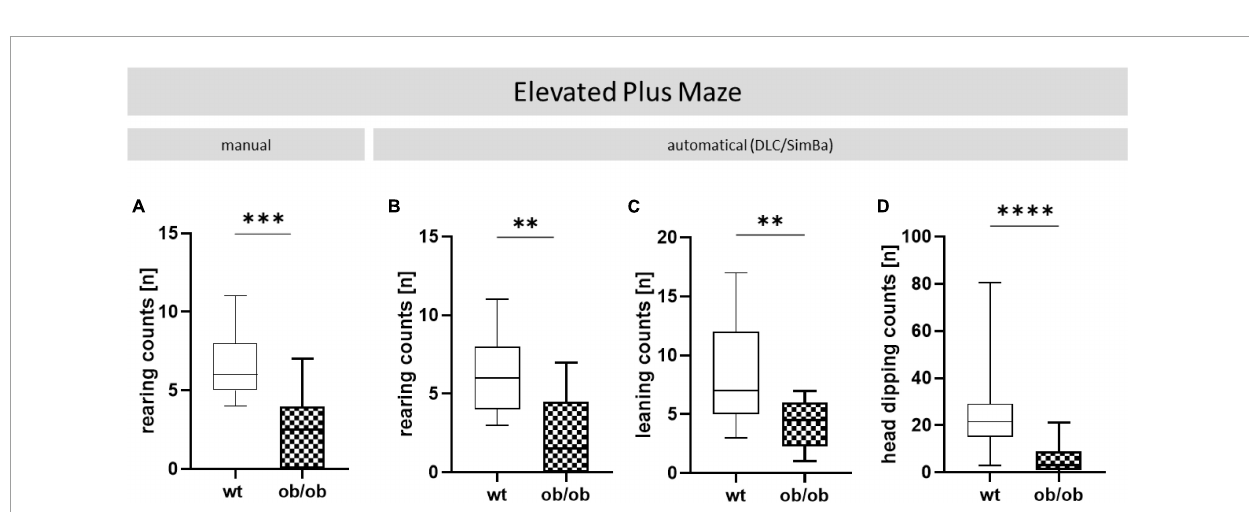
FIGURE6 Additional parameters collected in the EPM. Wt and ob/ob mice were comparatively analyzed. (A) Rearing counts (n) manually scored by an observer via video analysis and (B) obtained automatically with DeepLabCut (DLC). Furthermore, (C) leaning (n), and (D) head dipping counts (n) were observed with DLC. Group size was as follows: n (wt) = 11 (A–C) , 46 (D) and, n (ob/ob) = 12 (A) , 10 (B) , 8 (C) , and 42 (D) . Significance of differences between the groups were tested by unpaired Student’s t -test. Statistical significance was set at ∗∗ p < 0.01, ∗∗∗ p < 0.001, and ∗∗∗∗ p <